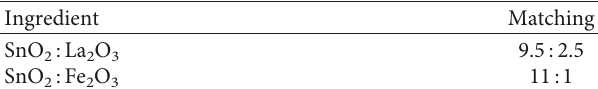
2 /La 2 O 3 contact